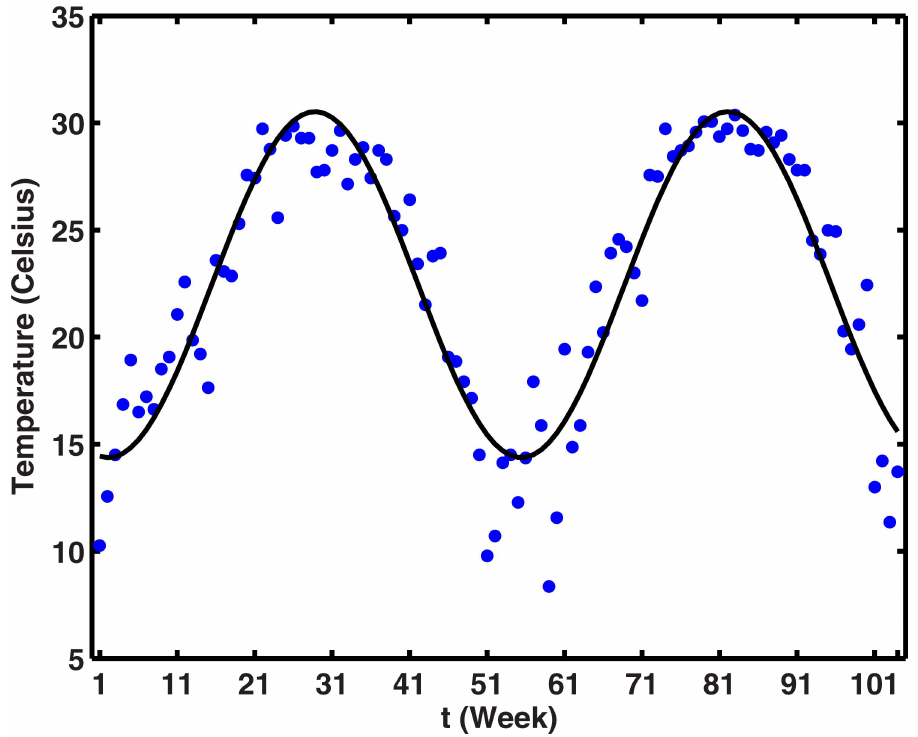
Fig 5. The comparison between the 2014 reported weekly averagetemperature and the simulated result with Eq (9). The blue dots indicate weeklyaveragetemperature in Guangzhou,whileblack line shows model